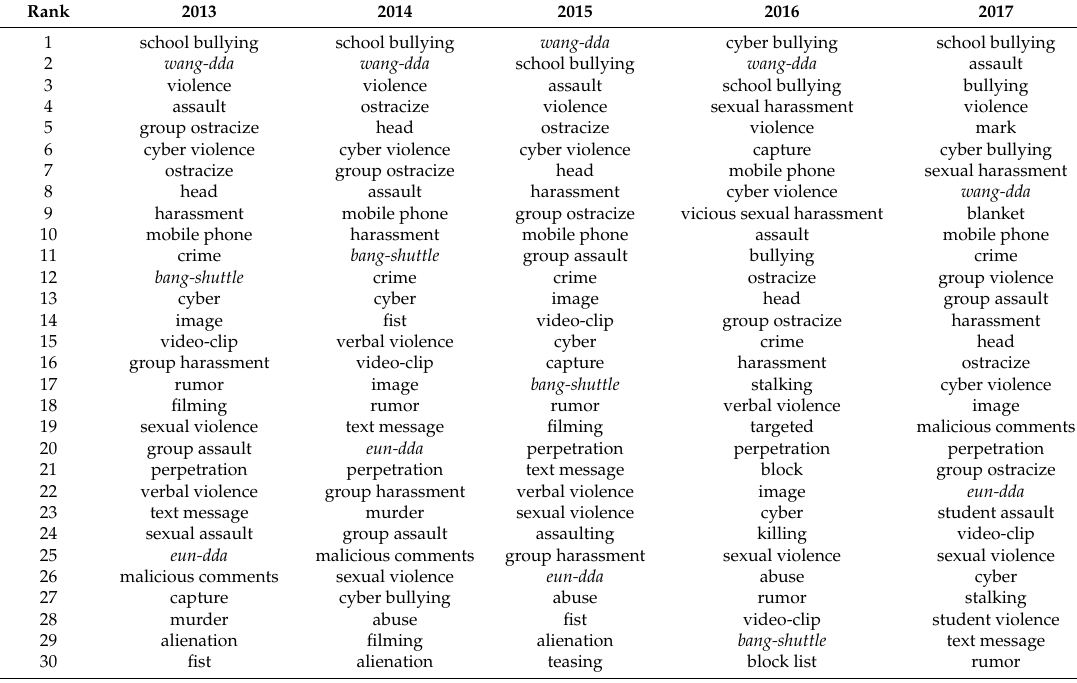
Table 1. Top 30 words as determined by Term Frequency-Inverse Document Frequency (TF-IDF). Rank